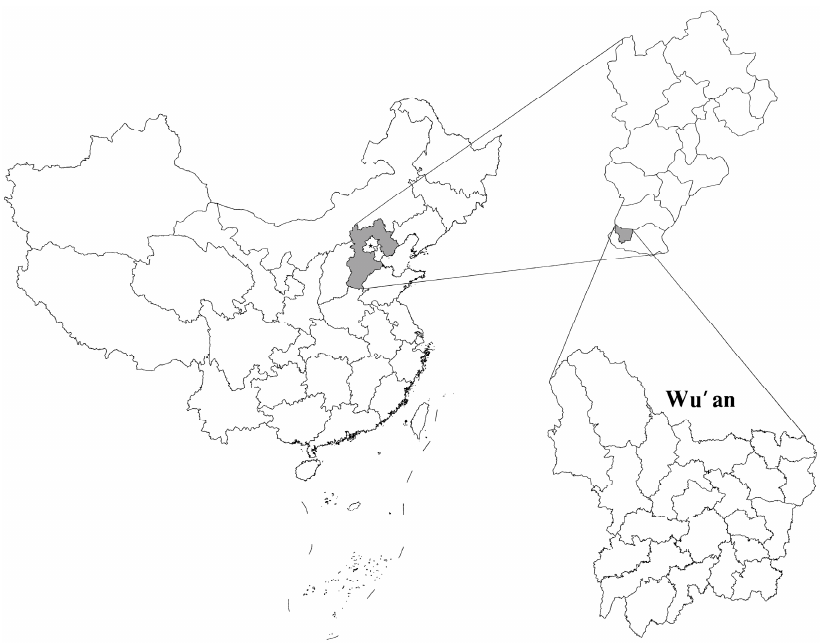
Figure 1. Location of Wu’an in the Hebei Province of China.